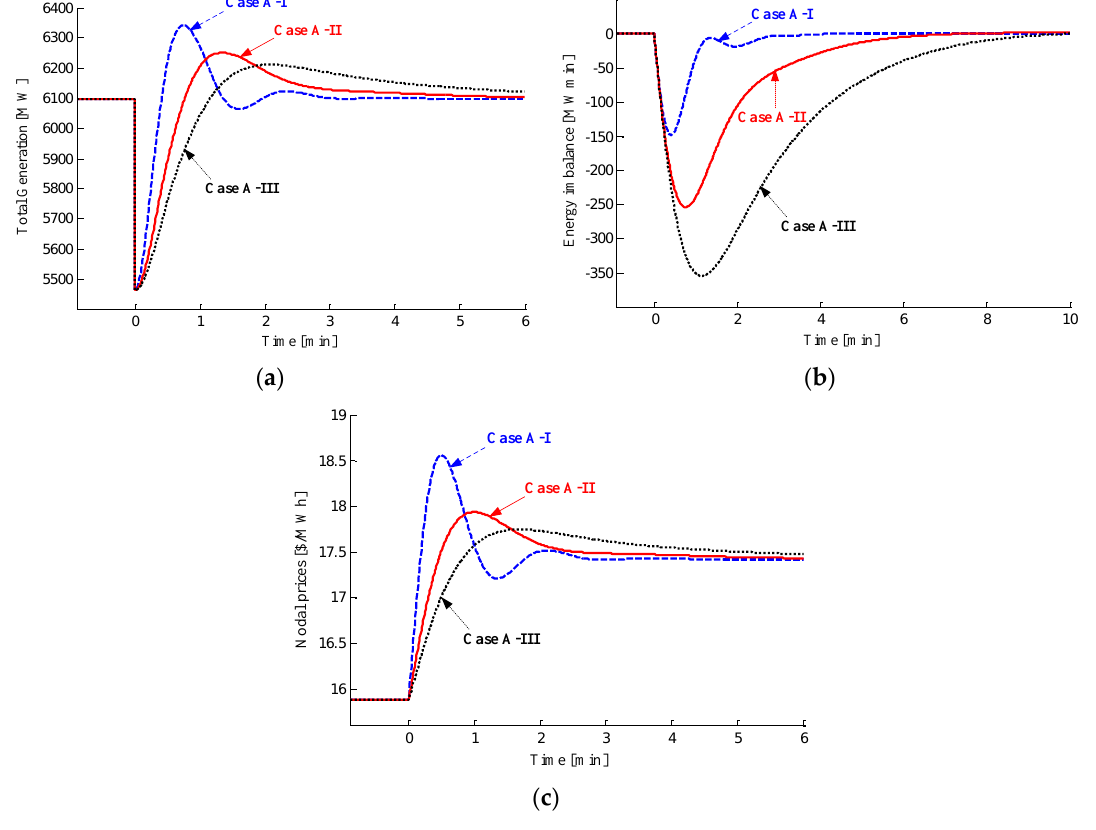
Figure 5. Simulation results for generation failure at the bus 33: ( a ) total amount of generation; ( b ) energy imbalance; and ( c ) nodal prices.